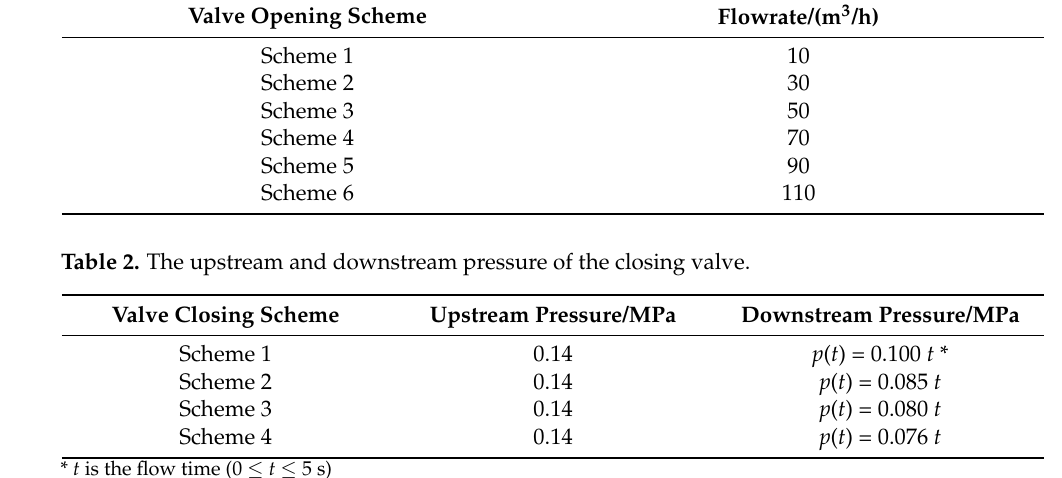
Table 1. The valve opening flow rates under each opening scheme.